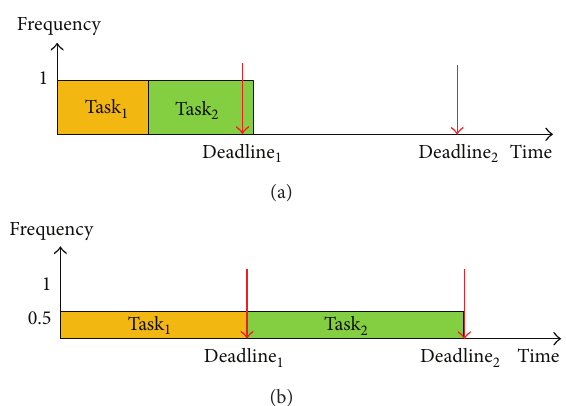
Figure 1: Scaling voltage and frequency at task slack time. (a) Without DVFS and (b) with DVFS.